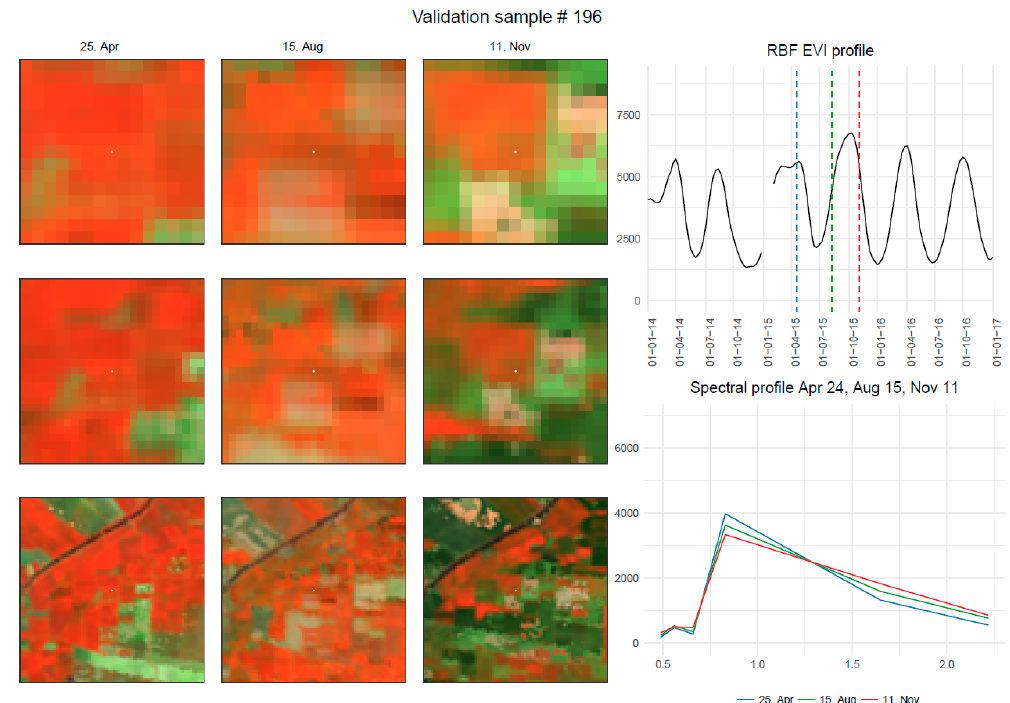
Figure A4. Validation pixel protocol for class double cropping.